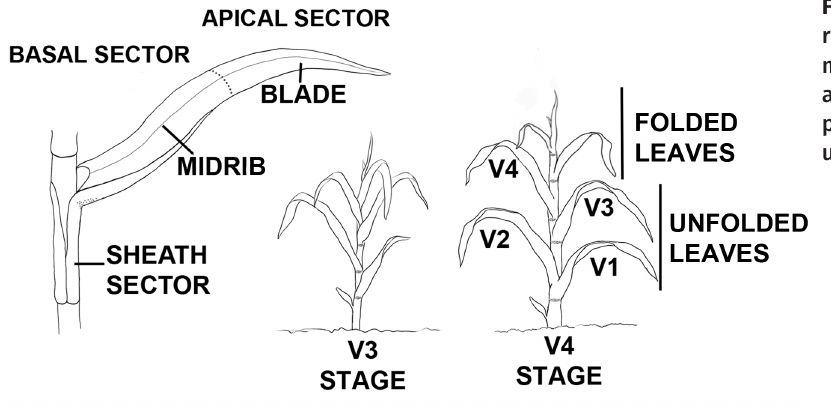
refer to parasitism as the number of eggs with parasitism over the number of eggs, taking values between 0 and 1. The fixed effects were leaf class (folded and unfolded leaves) and position in the leaf (sheath, basal or apical blade, basal or apical midrib). Eggs were not detected in the